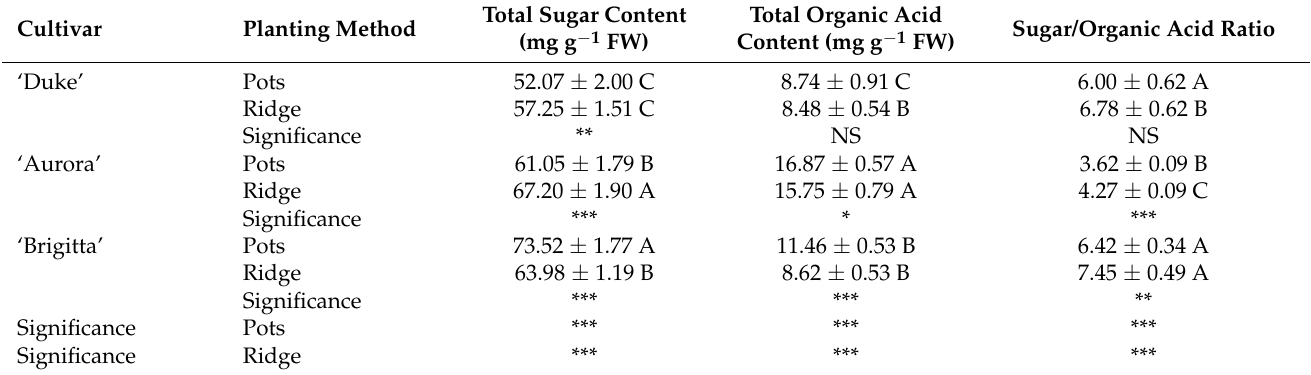
Table 2. Total sugar and organic acid contents and sugar/organic acid ratios for ‘Duke’, ‘Aurora’, and ‘Brigitta’ blueberry fruit harvested from plants grown in pots and along the ridge.